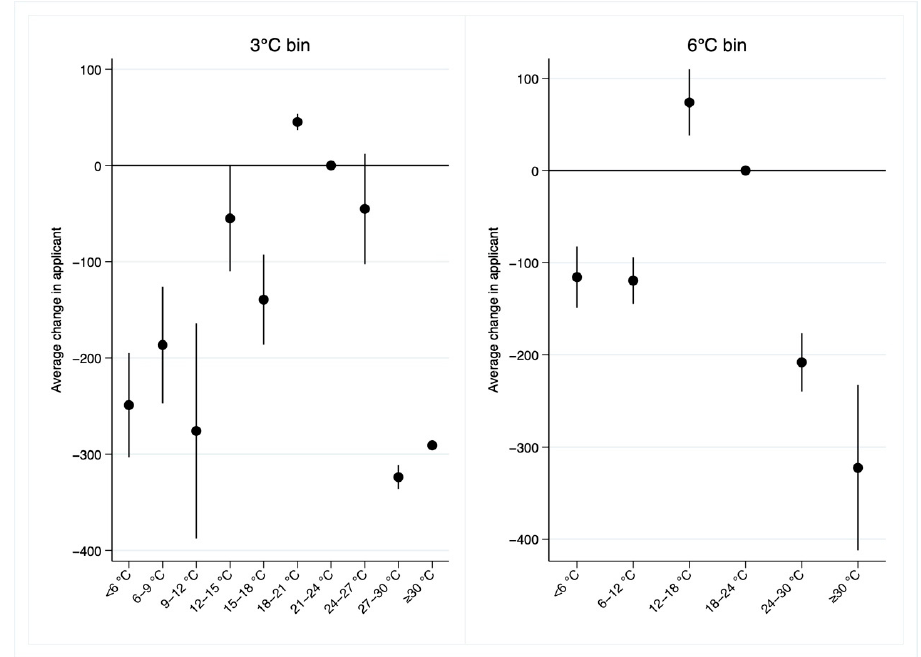
Figure 8. Estimated impacts of average temperature on the number of applicants for the UNGEE using alternative temperature bins.